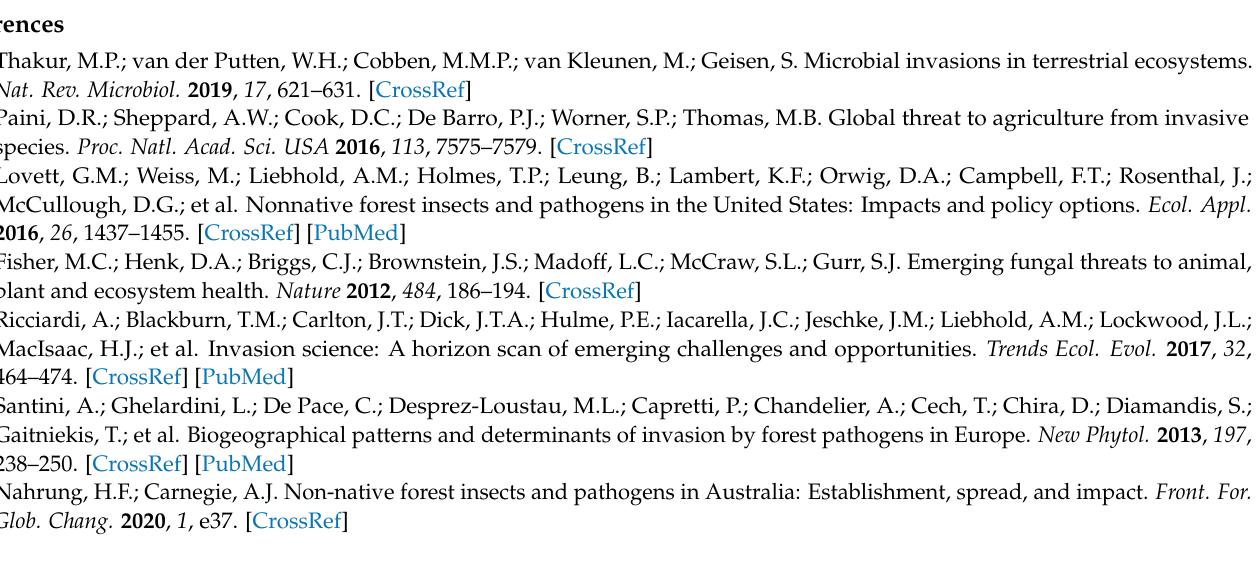
Cps ; Figure S2: Eigenvectors (loadings) of the principal component analysis of 27 bioclimatic variables used for producing correlative models; Figure S3: Mobility-oriented parity (MOP) assessment outputs for correlative model projections; Figure S4: Maps of climatic suitability for Cps in New Zealand. Figure S5: Maps depicting predictions of the accumulation of (a) cold stress, (b) heat stress, and (c) dry stress at a global scale produced by CLIMEX. File S1: Presence records used for fitting and validating climatic suitability models for Calonectria pseudonaviculata. The geographic origin (continent, country, region, site name, and geographic coordinates), year of collection if known (i.e., when the pathogen was detected), and data source for each record are indicated. The “Corr_mod” column indicates whether the record was used for fitting and testing correlative models. Site information for seven Oregon records are not provided due to confidentiality